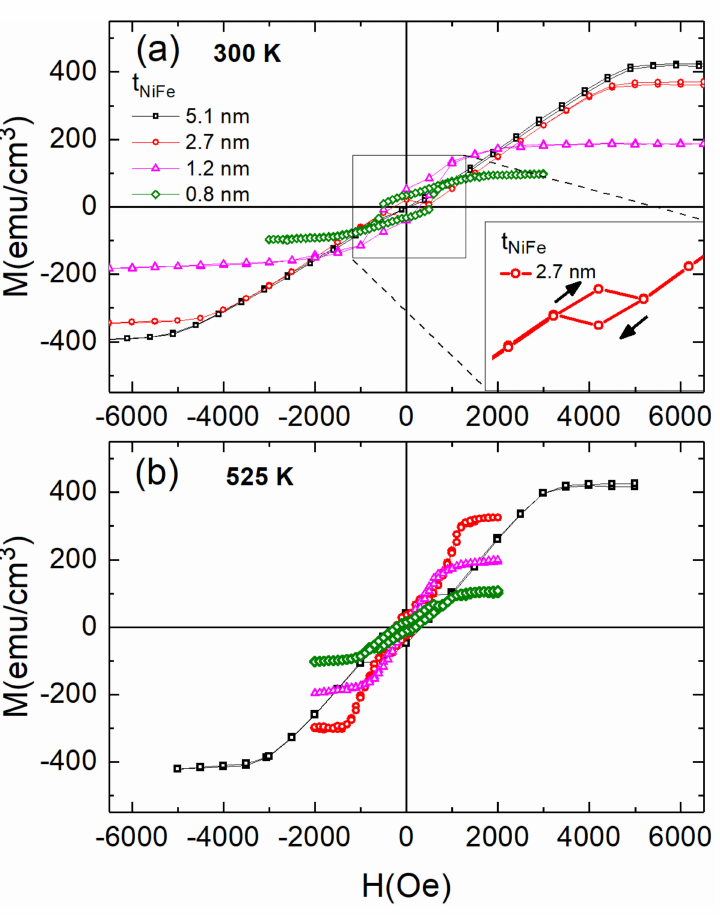
Figure 3. RT polar MOKE hysteresis loops (H is applied along the film normal) for four NiFe/NiFeO multilayers with t NiFe as indicated, before ( a ) (top) and after annealing at 525 K for 90 min ( b ). In the inset, the magnification of the data near zero magnetic field for a sample with t NiFe = 2.7 nm is shown, which presents inverted hysteresis with negative